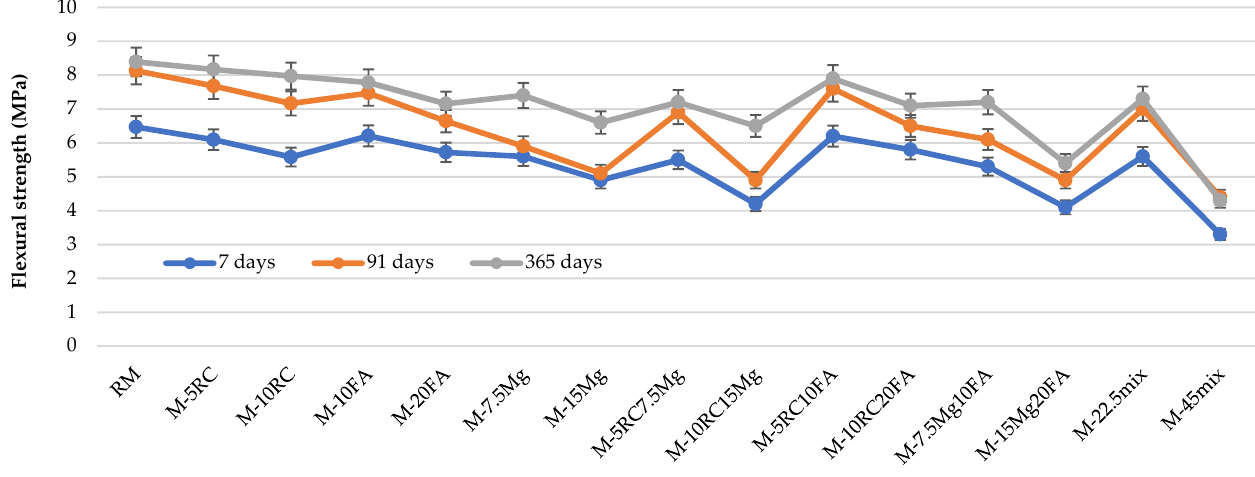
Figure 3. Flexural strength between 7 and 365 days of curing.